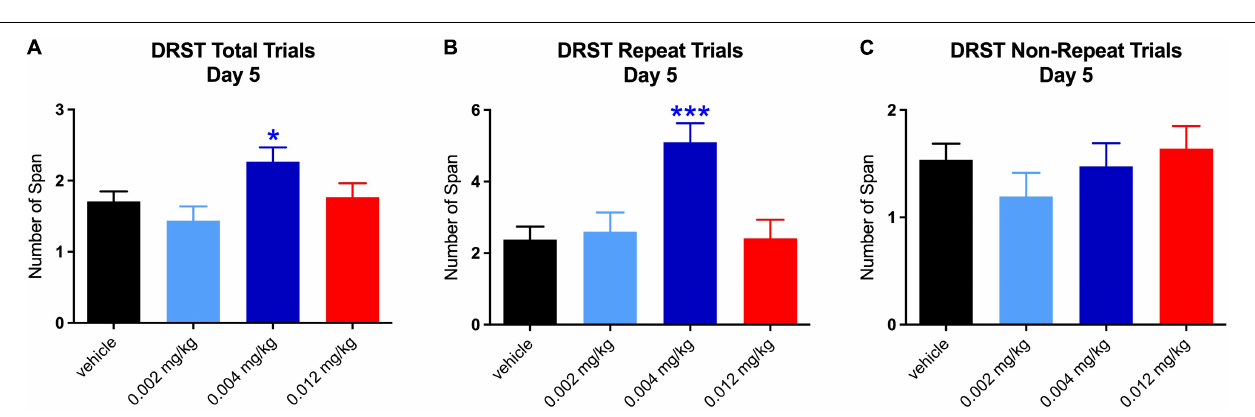
FIGURE 5 | Effect of PF-6294 on DRST Spatial Performance on Day 5. (A–C) The increase in total span on day 5 for the middle dose (* p = 0.035) was seen only on repeated trials (*** p = 0.0001). Error bars =